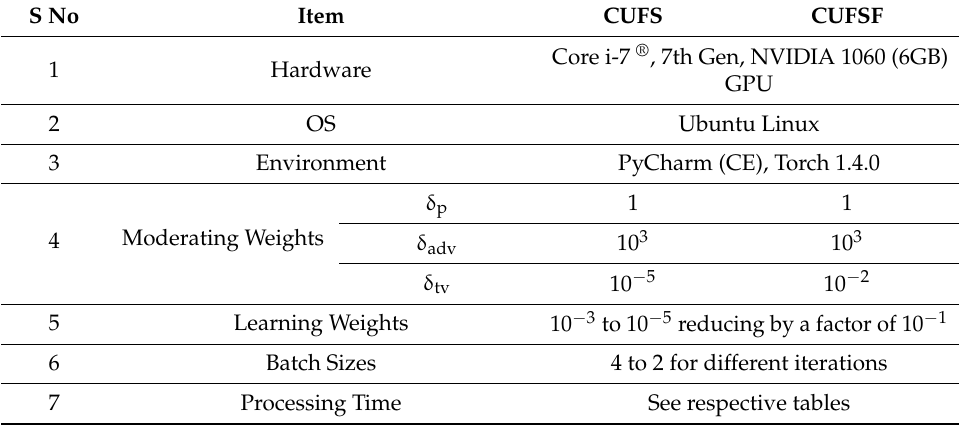
Table 2. Parameters for processing.